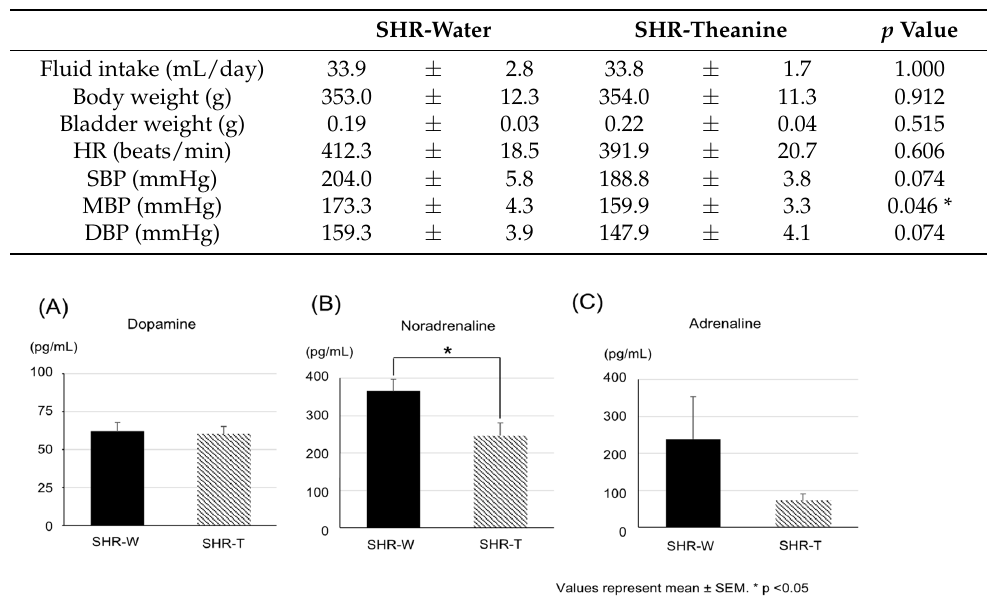
Figure 1. Mean serum catecholamine concentrations after 6weeks of administration: ( A ) serum dopamine concentration, ( B ) serum noradrenaline concentration, and ( C ) serum adrenaline concentration of rats assigned to the two groups. Serum noradrenaline concentration was significantly lower in the SHR–theanine group than in the SHR–water group. Data are presented as mean ± standard error of the mean. * Statistical significance at the p < 0.05 level.